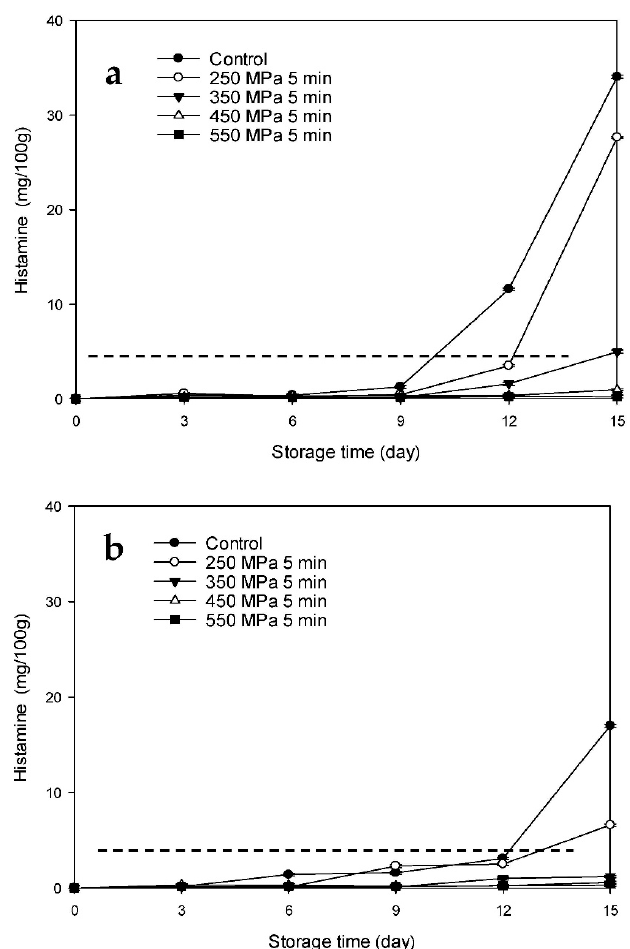
Figure 8. Changes in histamine contents of tuna meat samples inoculated with ( a ) Morganella morganii and ( b ) Photobacterium phosphoreum after high-pressure processing treatment at 250, 350, 450, and 550 MPa for 5 min during storage at 4 °C; dash line indicates the USFDA tolerance limit of 5.0 mg/100 g of histamine.